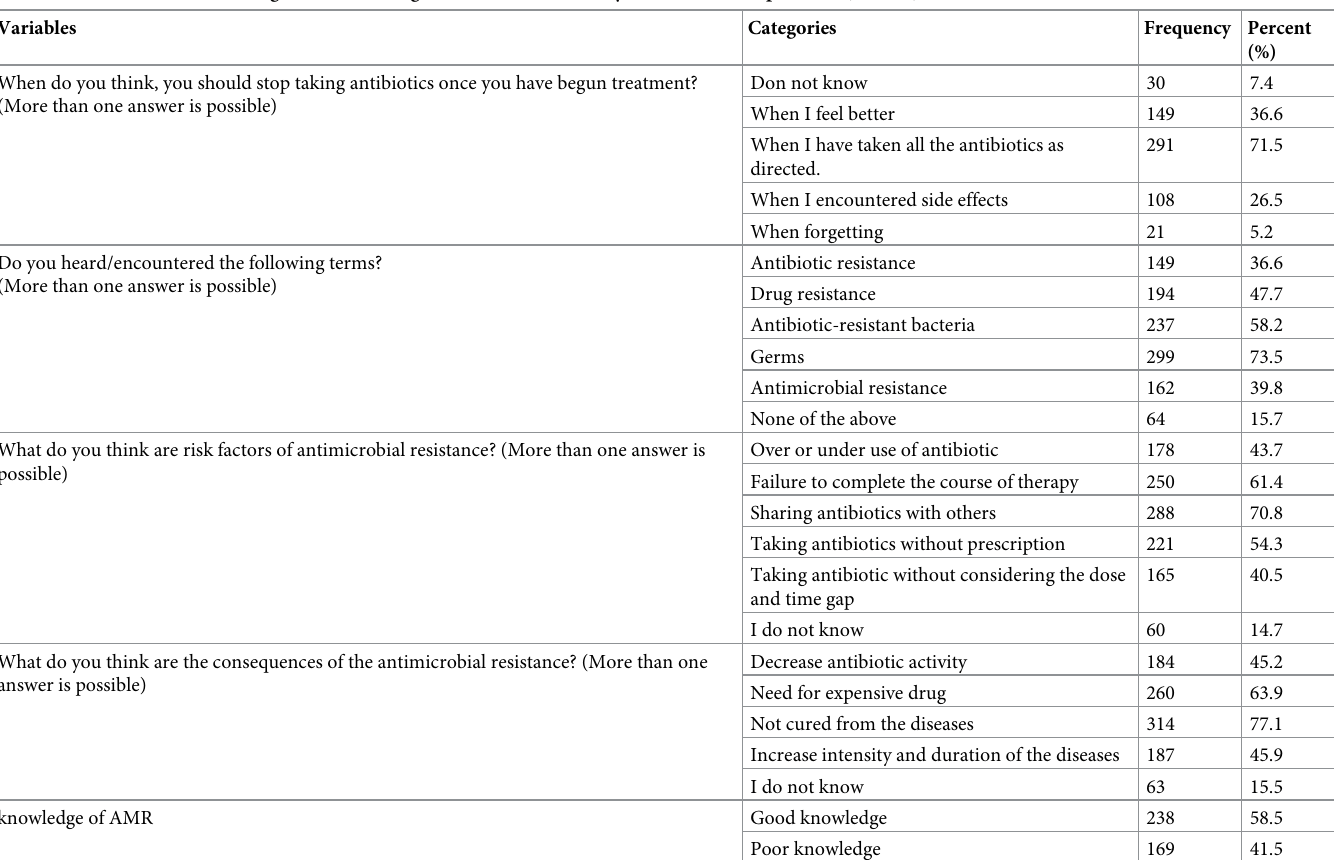
Table 3. Awareness and knowledge of AMR among the adults of Dessie City, Northeast Ethiopia, 2021 (n = 407).